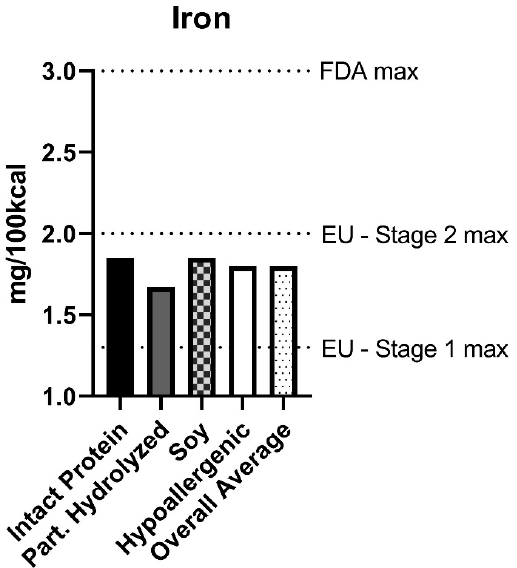
Figure 2. Iron content of infant formula purchased in the US between 2017–2019. Powdered infant formula purchased from all major physical retailers (excluding Costco) in the US between 2017–2019. Average iron content (mg/100 kcal), controlling for volume purchased, is reported in each category of formula. Horizontal lines represent the European Union (EU) maximum allowable iron concentration for Stage 1 and 2 formula and the Food and Drug Administration (FDA) maximum allowable iron concentration for all US infant